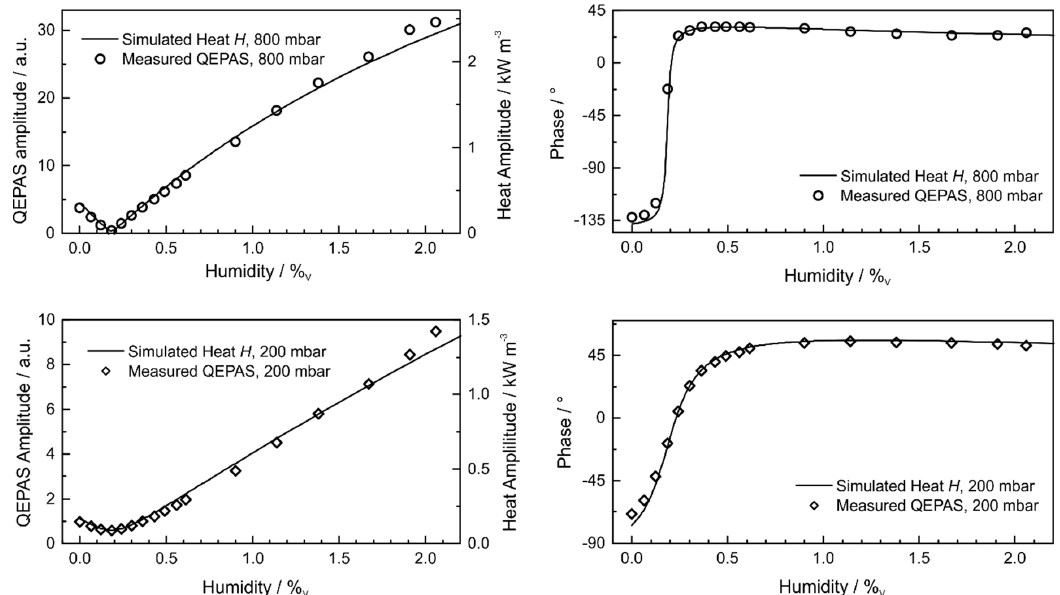
Figure 4. Simulation of the photothermal response ˆ H and measured QEPAS signal of CO in N 2 at varying humidities and conditions identical to those in Figure 2. The QEPAS phase was inverted and shifted with respect to Figure 2 to resemble the simulations (see text).